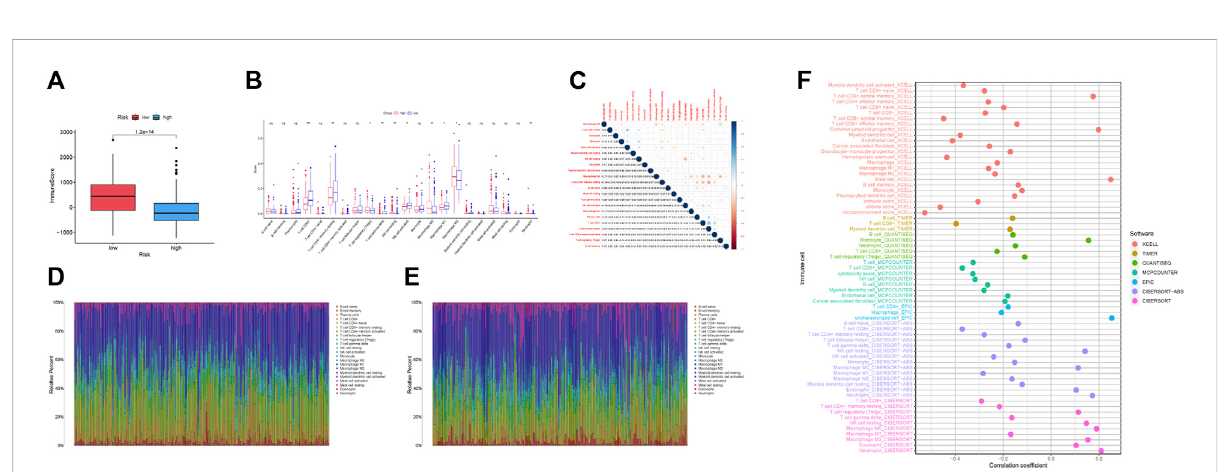
FIGURE 8 Immunological correlation and immune differential studies were performed on two groups of HCC patients. (A) Boxplots showed the ImmuneScore is signi fi cantly higher in low-risk group. (B) The differential analyses of immune cells for two groups. (C) The correlation plot of immune cells. (D) Distribution of 22 in fi ltrating immune cell subtypes in the low-risk group. (E) Distribution of 22 in fi ltrating immune cell subtypes in high-risk group. (F) Relationship between different immune cells and risk